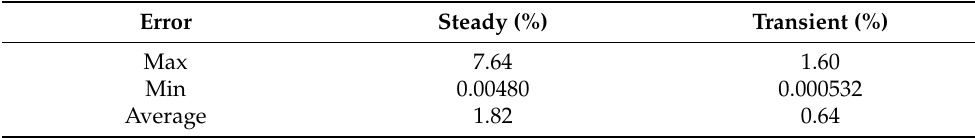
Table 5. Comparison of physical